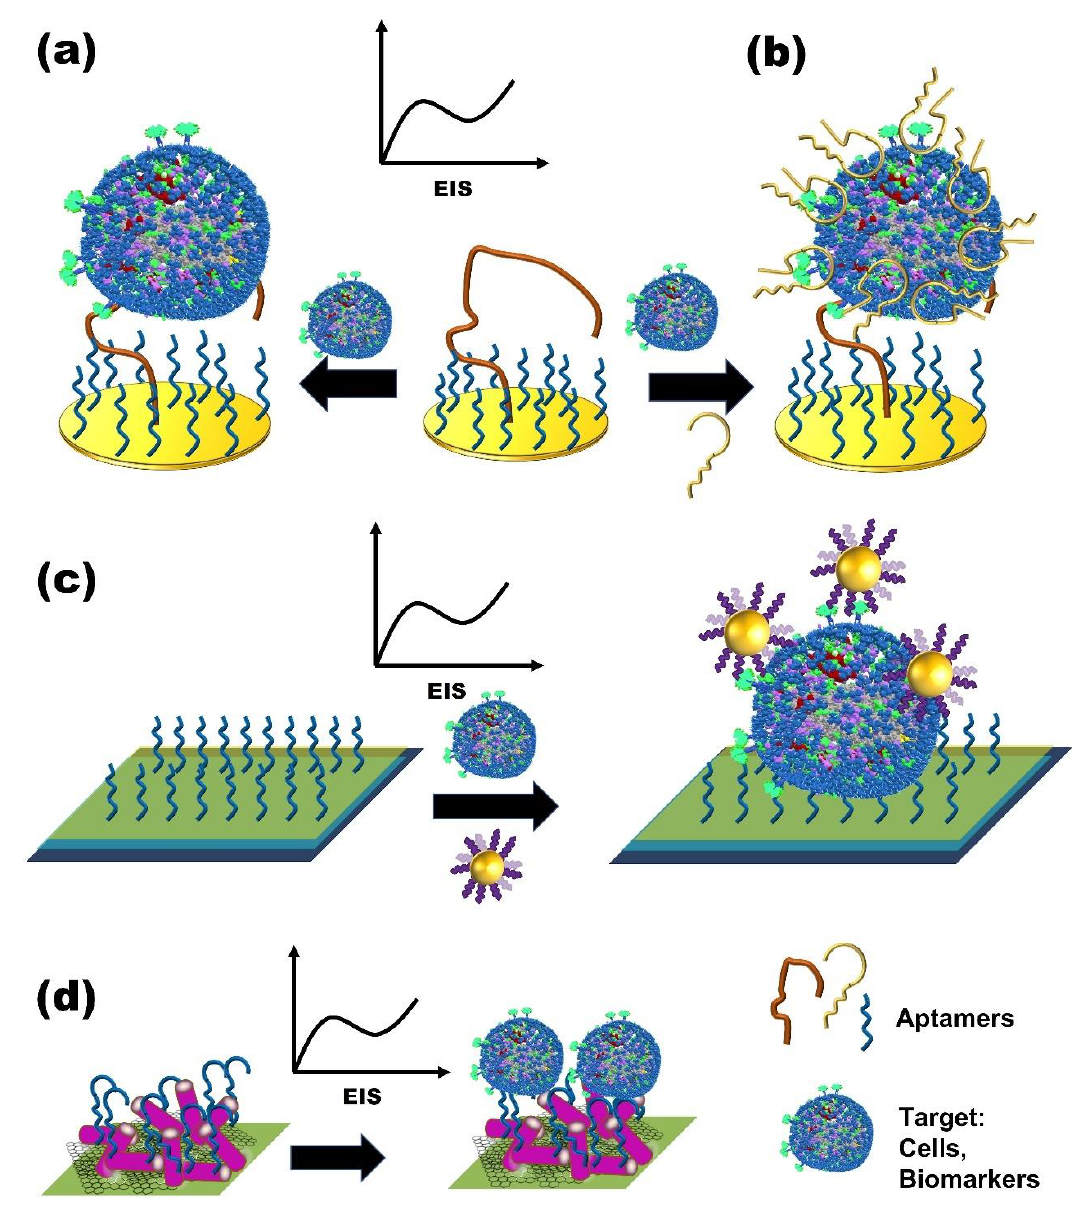
Figure 3. Schematic presentation of label-free electrochemical aptasensors. ( a , b ) Cell-based label-free electrochemical aptasensors. ( c , d ) Nanomaterial label-free electrochemical aptasensors.